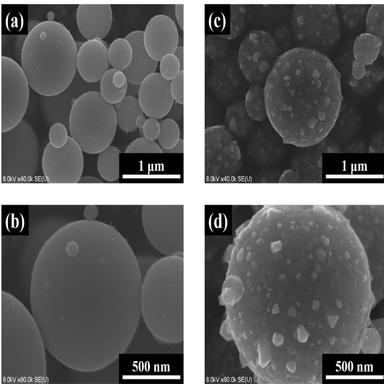
FE-SEM images of the C/Fe3O4 microspheres prepared by spray pyrolysis (a and b) and by steam oxidation (c and d).